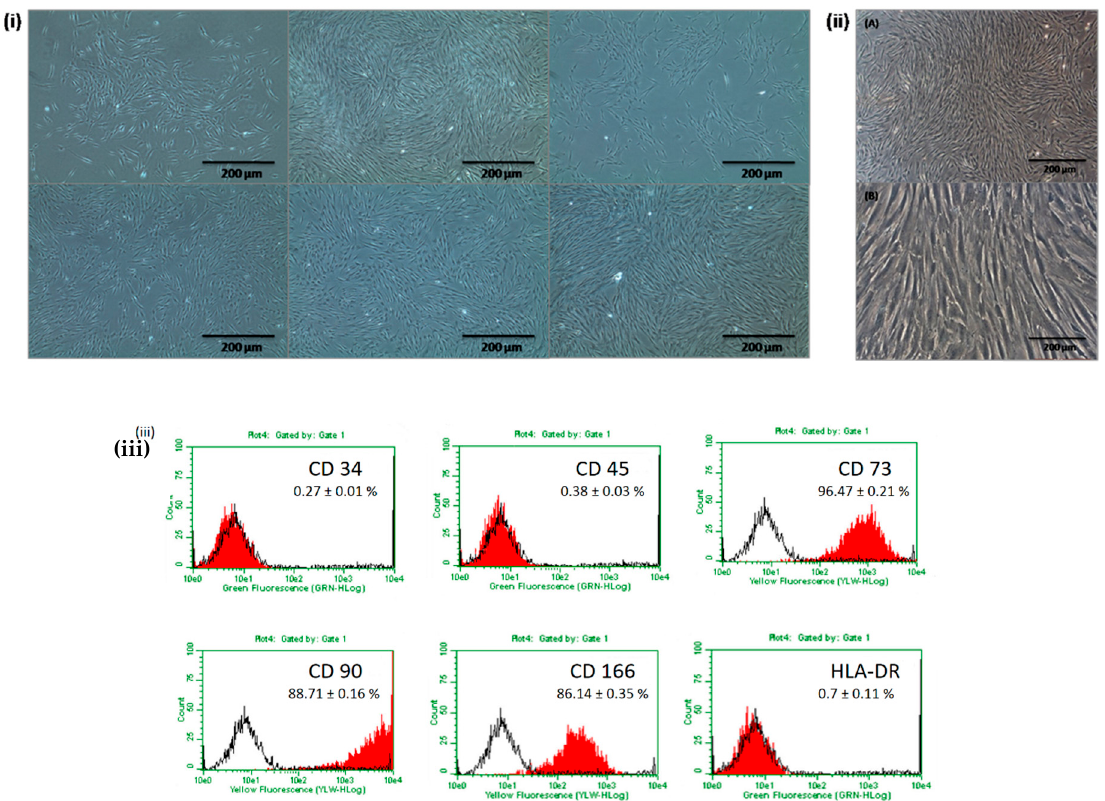
Figure 1. ( i ) Primary culture images obtained from 6 assays displaying the morphology of DPSCs (Magnification 4 × ; phase contrast images) ( ii ) Images of DPSCs expanded in FBS at subculture 3 (A: Magnification at 10 × ; B: Magnification at 20 × ; phase contrast images) ( iii ) Immunophenotype analysis of DPSCs expanded in FBS using flow cytometry. Cells were tested against human antigens CD34, CD45, CD73, CD90, CD166, and HLA-DR.